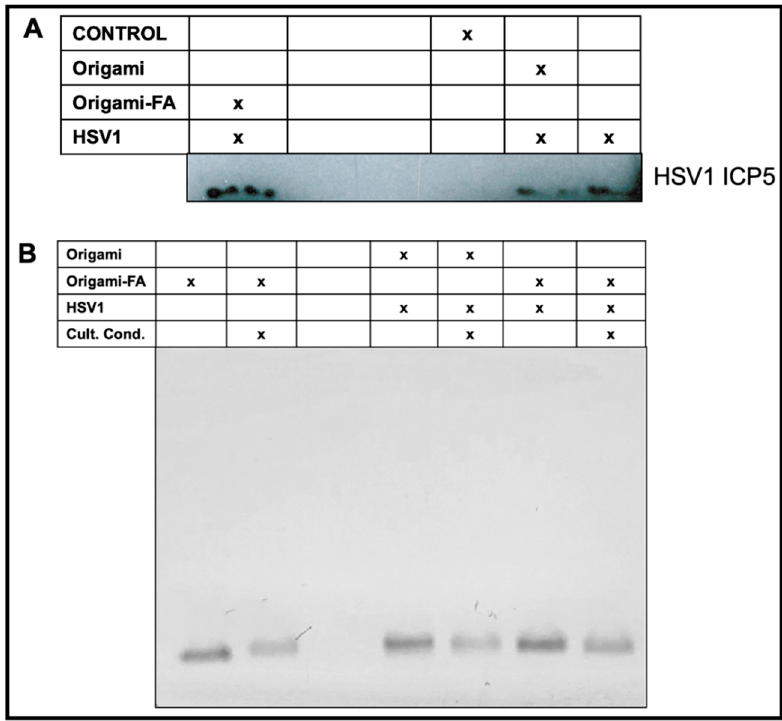
Figure 5. Validated HSV1 delivery and packaging stability of the Origami-HSV1 complexes in vitro. ( A ) Western Blot characterization on produced ICP5 HSV1 Major Capsid after HSV1 infection based on delivery or masking method. ( B ) Validated stability of the Folate-adorned Origami-HSV1 complexes in vitro under cell culture conditions identical to the conditions during the plaque assay inoculum stage. The corresponding table legends for ( A , B ) indicate the present entities and conditions for each sample in each lane.